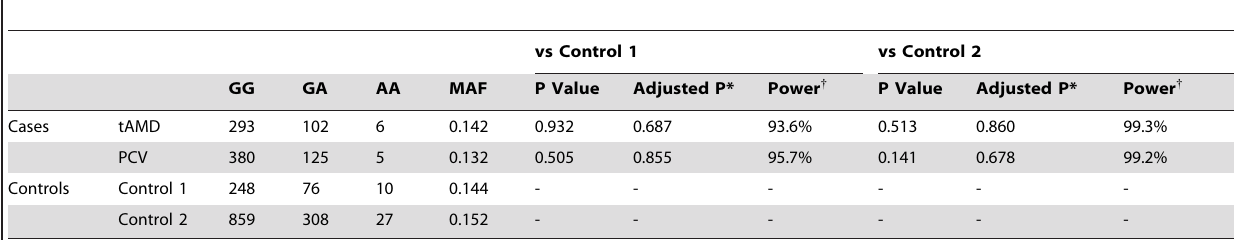
Table 2. SERPING1 rs2511989 Genotypic Distributions and Results of Association Tests and Power Analysis.